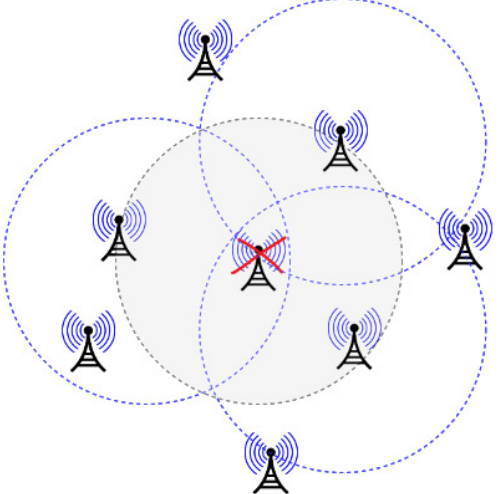
Figure 5. Monitoring Station Election